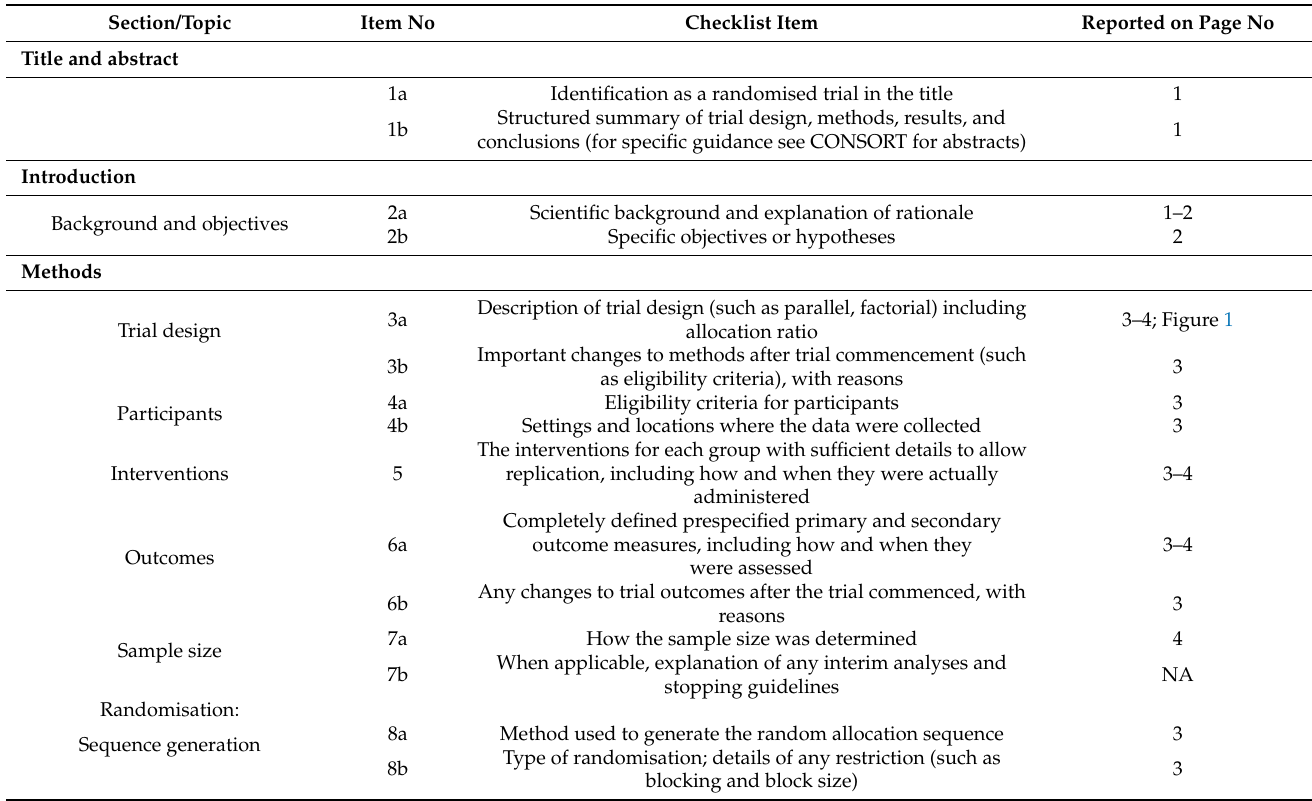
Table A1. CONSORT checklist of the